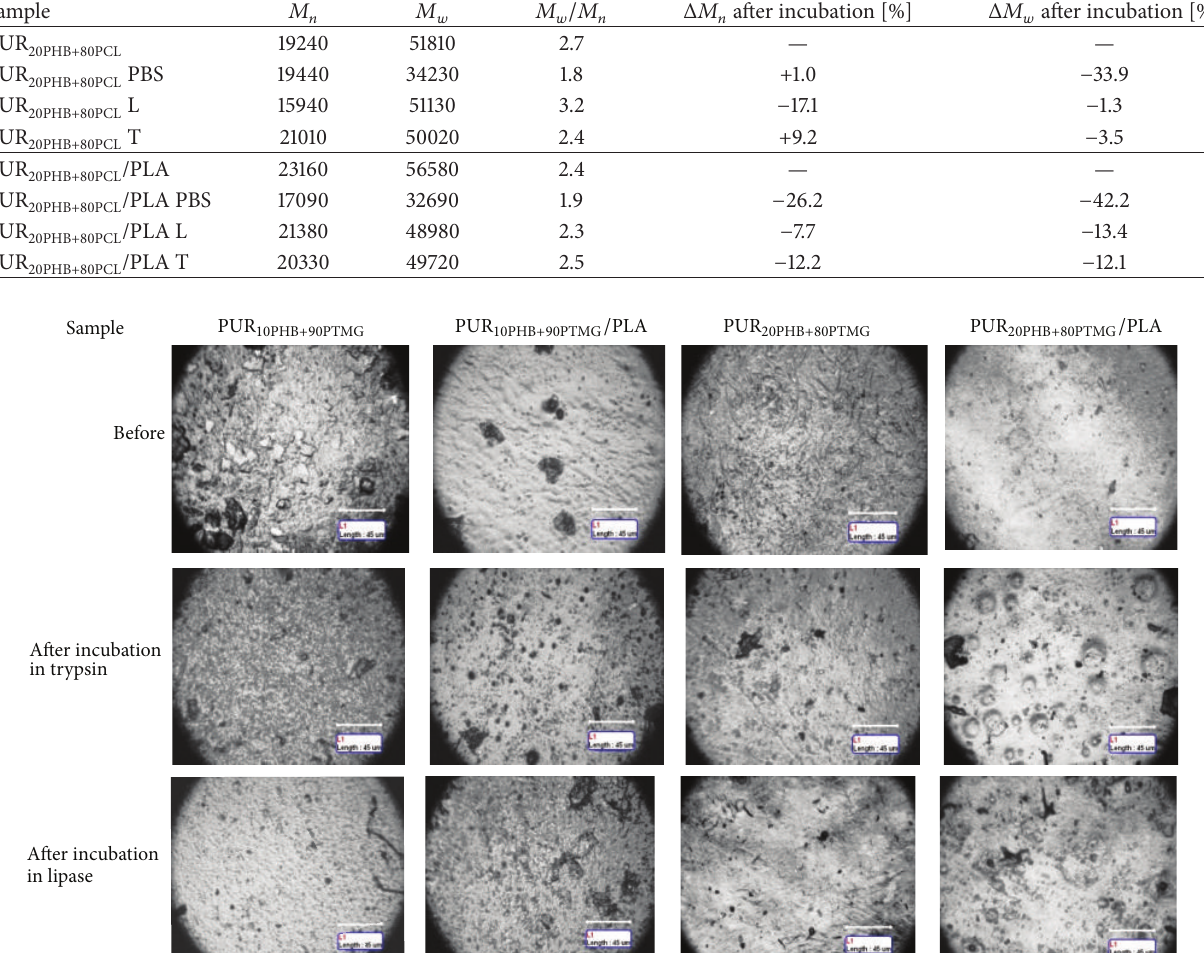
Table 7: Molecular weights of polyurethane (PUR (L), and trypsin (T).